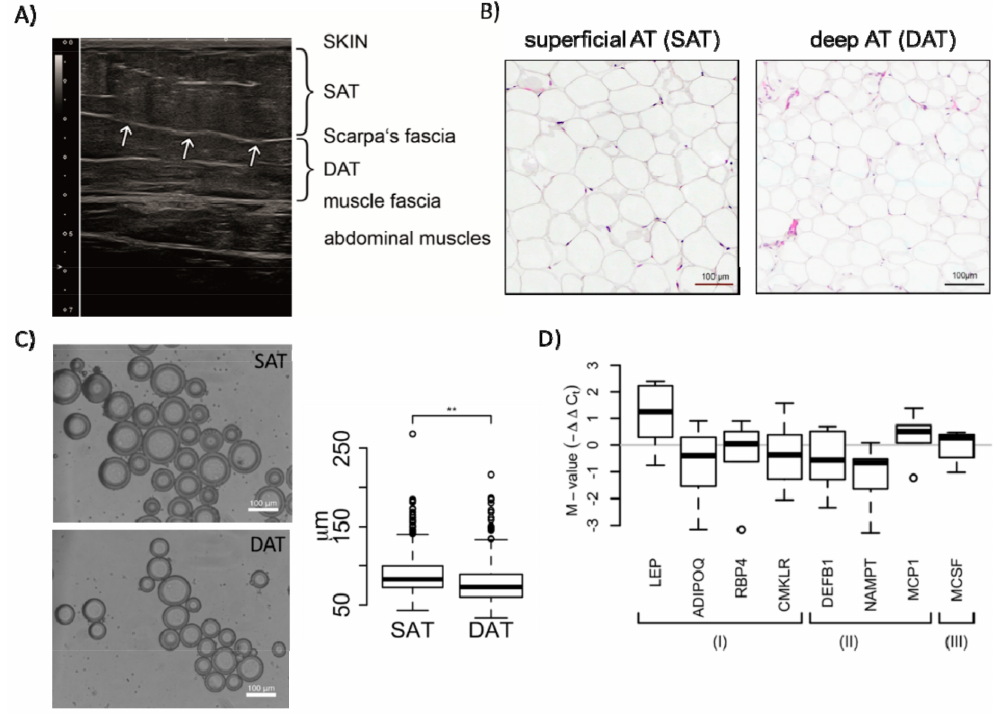
Figure 1. Morphological and paracrine characterization of superficial adipose tissue (SAT) and deep adipose tissue (DAT) adipocytes. ( A ) Representative ultrasound image of infraumbilical subcutaneous fat tissue showing the two individual subcutaneous fat layers. The arrows indicate the Scarpa’s fascia. Obviously, a higher level of hyperechogenic connective tissue structures was observed in DAT indicating structural fat tissue architecture and functional differences; ( B ) images of H&E-stained SAT and DAT cross-sections; ( C ) microscopy and quantitative analyses of freshly isolated adipocytes from SAT or DAT. The box plot represents data from a total of 2167 analysed adipocytes isolated from 3 female patients (Student’s t -test, ** p -values < 0.01); ( D ) RNA from SAT and DAT adipocytes was analysed for the expression of depicted cytokines by quantitative real time PCR. Expression values of indicated cytokines from six patients were normalized to the mean of three reference genes (GUSB, 18sRNA, and GAPDH) and are grouped according their function: (I) represents adipokines, (II) cytokines involved in inflammation and pathogen defence, (III) cytokine associated with neoangiogenesis. Shown are distributions of M-values (log2 fold-change values representing differential expression between SAT and DAT). Significance for difference of the means was calculated using a paired t